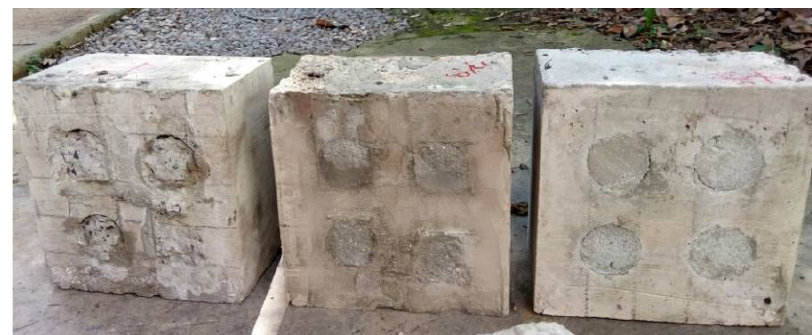
Figure 4 – Finalized repaired blocks with concrete, grout and dry pack (left to right)